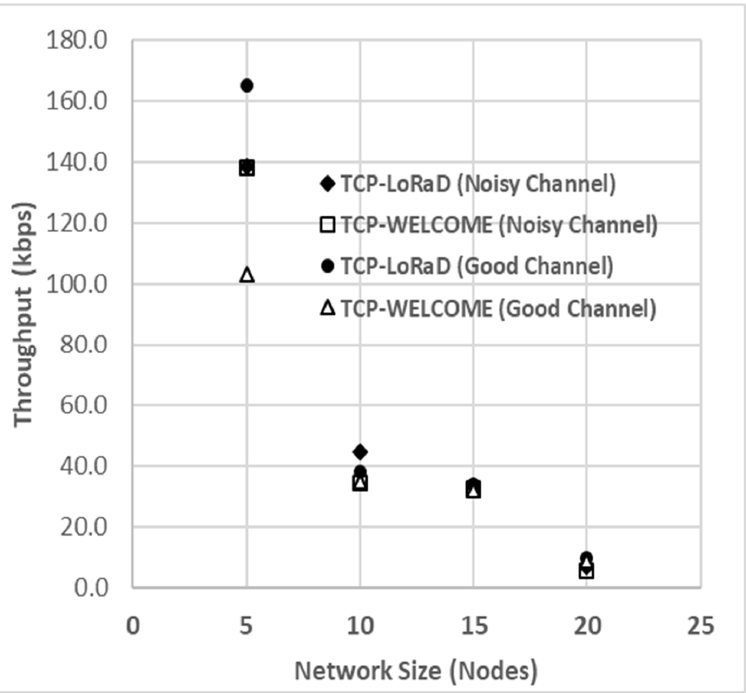
Figure 5. Throughput versus increasing the number of nodes in a noisy channel. Comparison of TCP-LoRaD and TCP-WELCOME. Results for good channel conditions are also presented for comparison purposes.